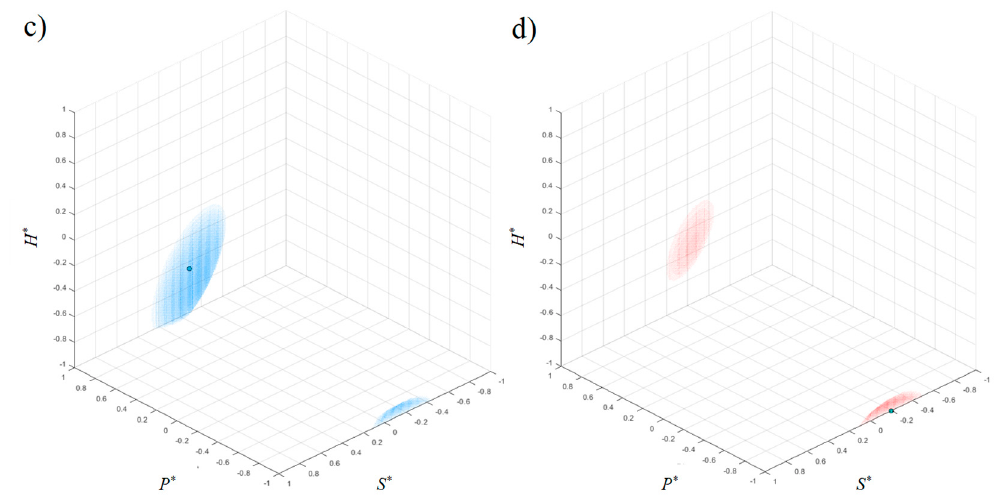
 , ( b )  , ( c )  and ( d ) A . Figure 13. With a tolerance of 1% for ( a ) σ 0.2 , ( b ) σ uts , ( c ) ε r and ( d ) A . 0.2 uts r